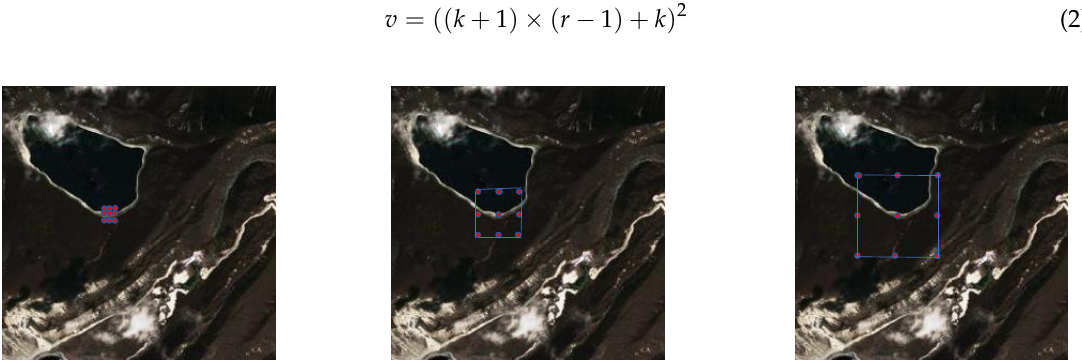
Figure 1. Dilated convolutions with rates of 1, 2, and 4, respectively. Dilated convolution supports the expansion of the receptive field without increasing the computation.